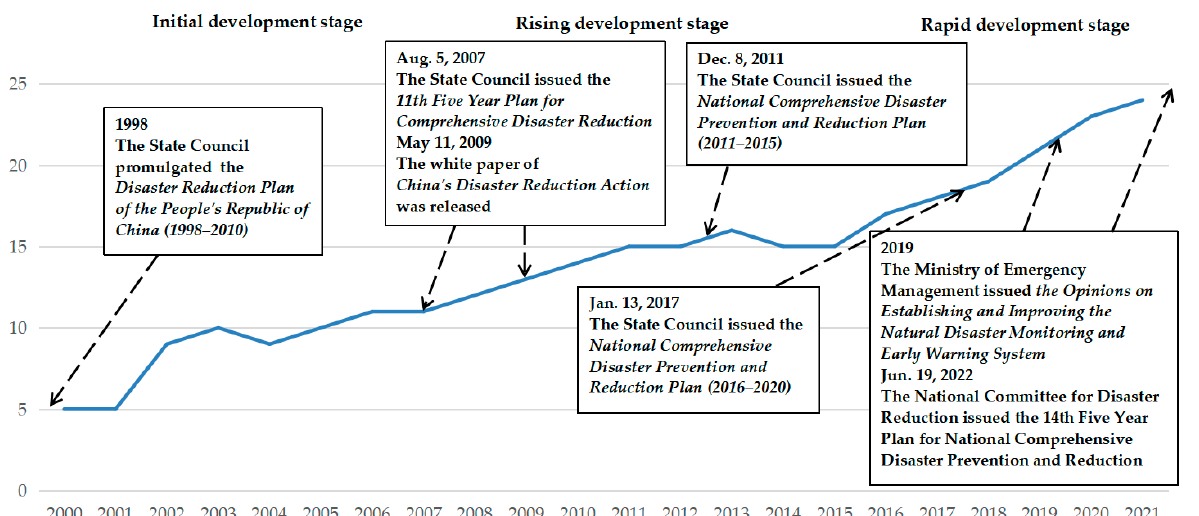
Figure 4. The development trend and stage division of China’s dynamic disaster monitoring and early warning national-level policy (2000–2021).